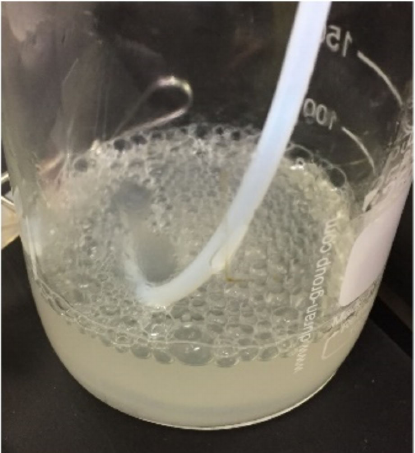
Figure 8. The CO 2 nanobubble medium that remained in the vial after the injection and was cultivated for 72 h along with the sand pack